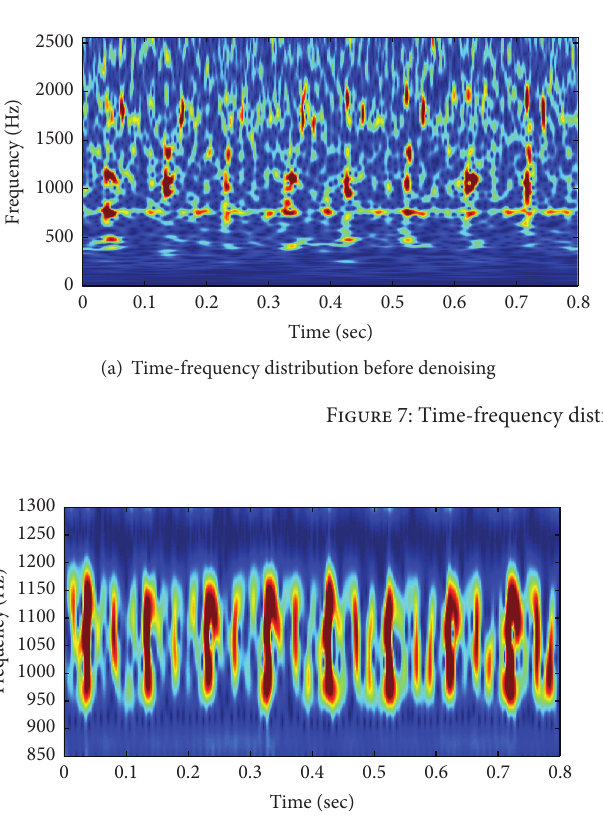
Figure 10: Envelope spectrum of reconstructed signal after